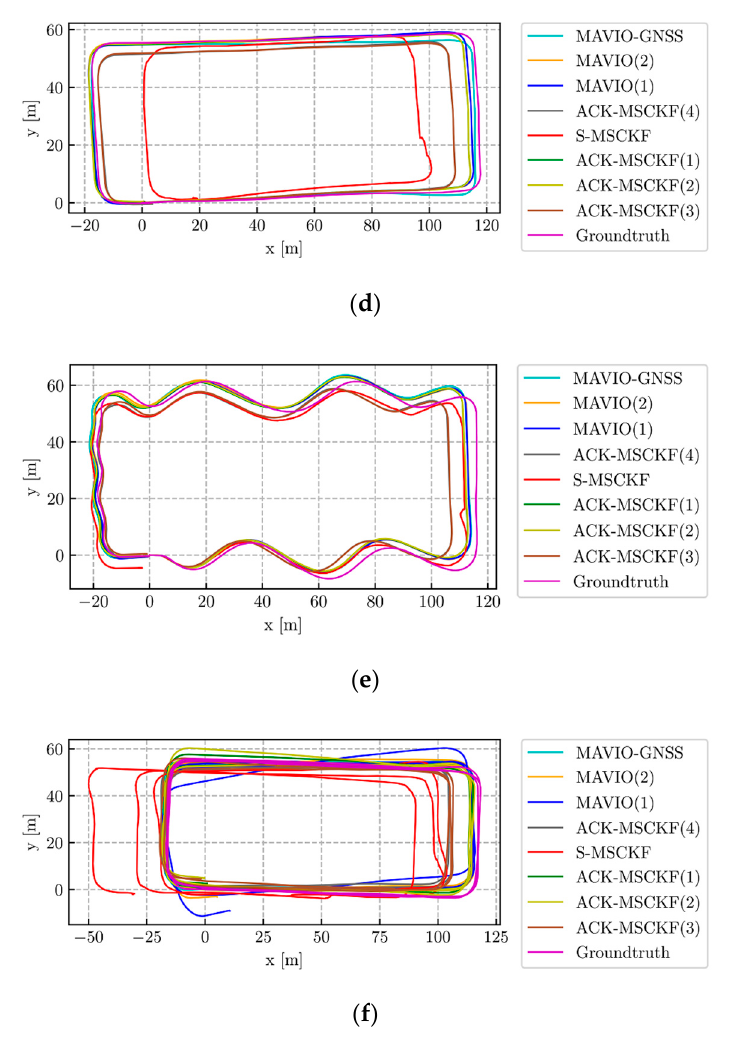
Figure 11. The top-views of estimated trajectories from MAVIO, MAVIO-GNSS, ACK-MSCKF, S-MSCKF and Groundtruth for the datasets: ( a ) VD01; ( b ) VD02; ( c ) VD03; ( d ) VD04; ( e ) VD05; ( f ) VD06.